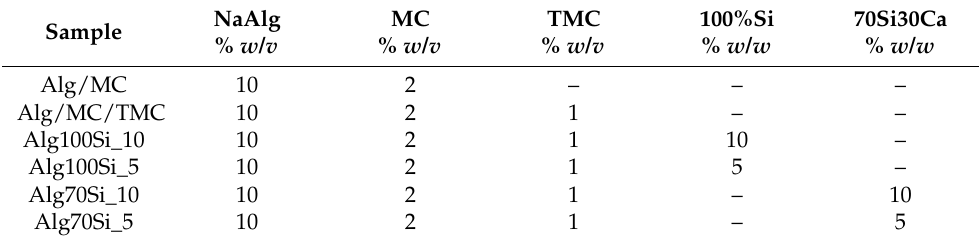
Table 1. Composition of the prepared